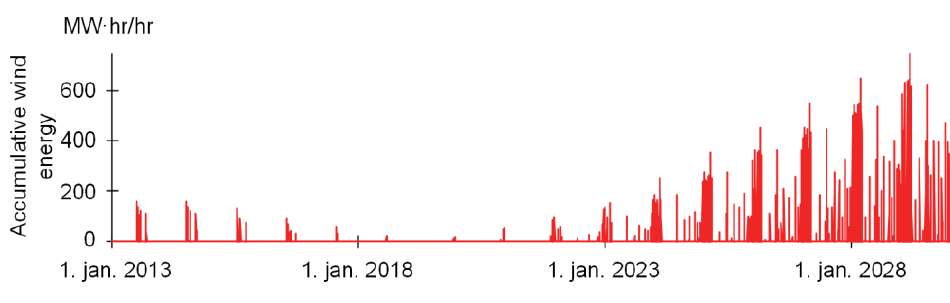
Fig. 8. The amount of accumulated wind energy in second